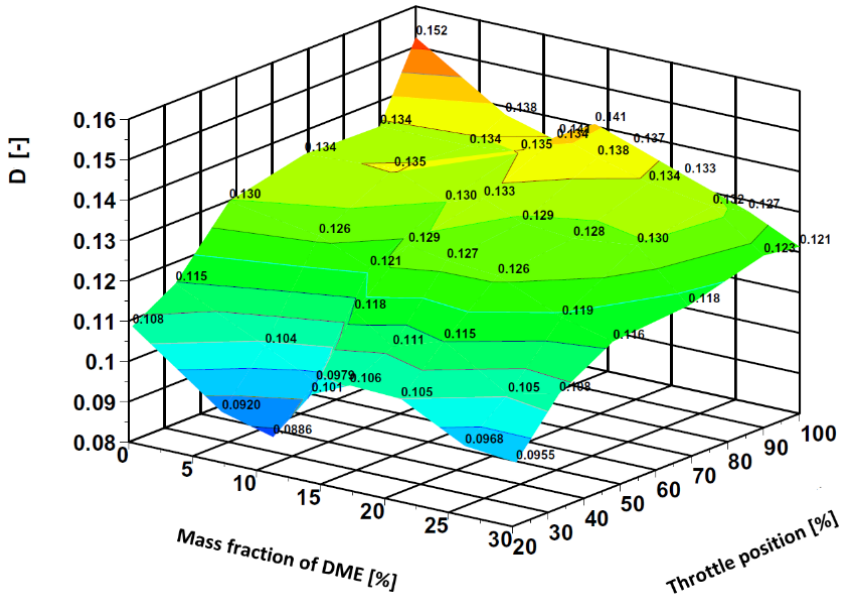
Figure 7. Values of the dynamic factor D for various shares of DME and load in the range: ( a ) 90%,